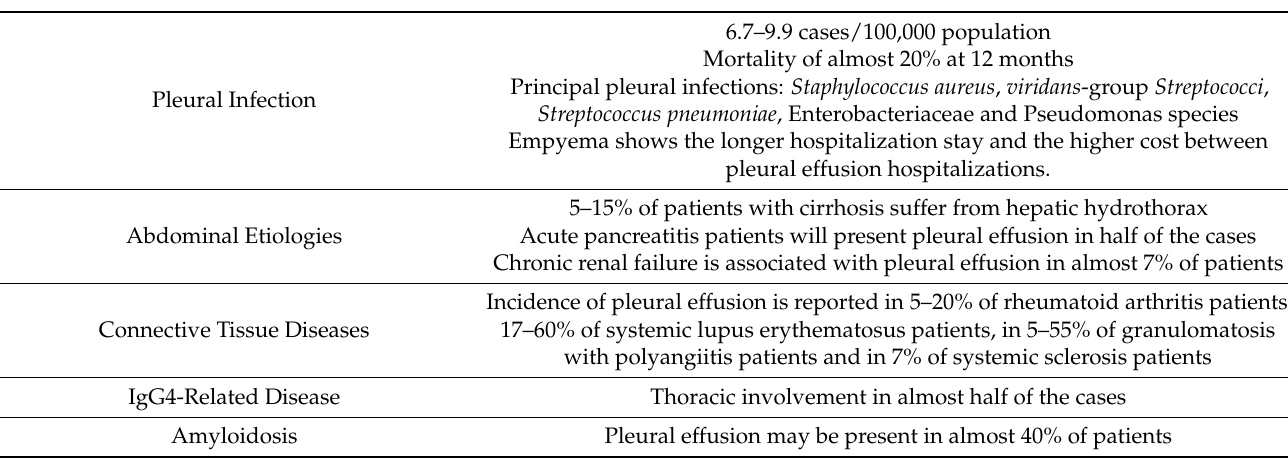
Table 1. Highlights on pleural effusion etiology.